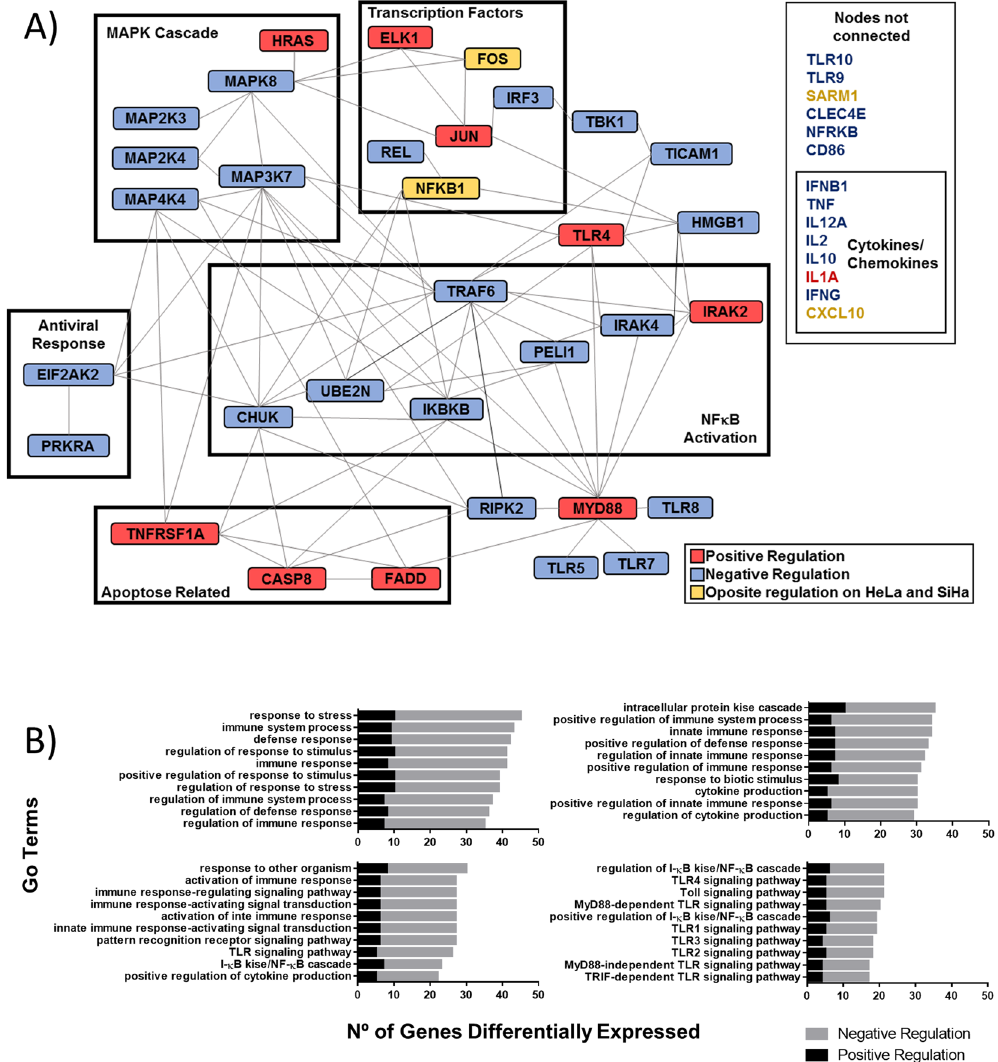
Figure 1. Cervical cancer cell lines exhibit altered mRNA expression of genes involved TLR-signaling pathway. ( A ) Pathway network analysis of 47 TLR pathway genes differentially expressed in HPV positive tumor cell lines (HeLa and SiHa) relative to HPV negative tumor cells (C33A). Genes clustered by protein function and delimited by boxes ( > 2-fold or < − 2-fold change and p value ≤ 0.05). Genes upregulated are red colored, genes downregulated are blue colored, and yellow-colored genes had opposite results in HeLa and SiHa cell lines (STRING: functional protein association networks, string-db.org/). ( B ) Biological processes distribution of genes differentially expressed in HPV positive tumor cell lines relative to HPV negative tumor cells. (WEB- based GEne SeT AnaLysis Toolkit,